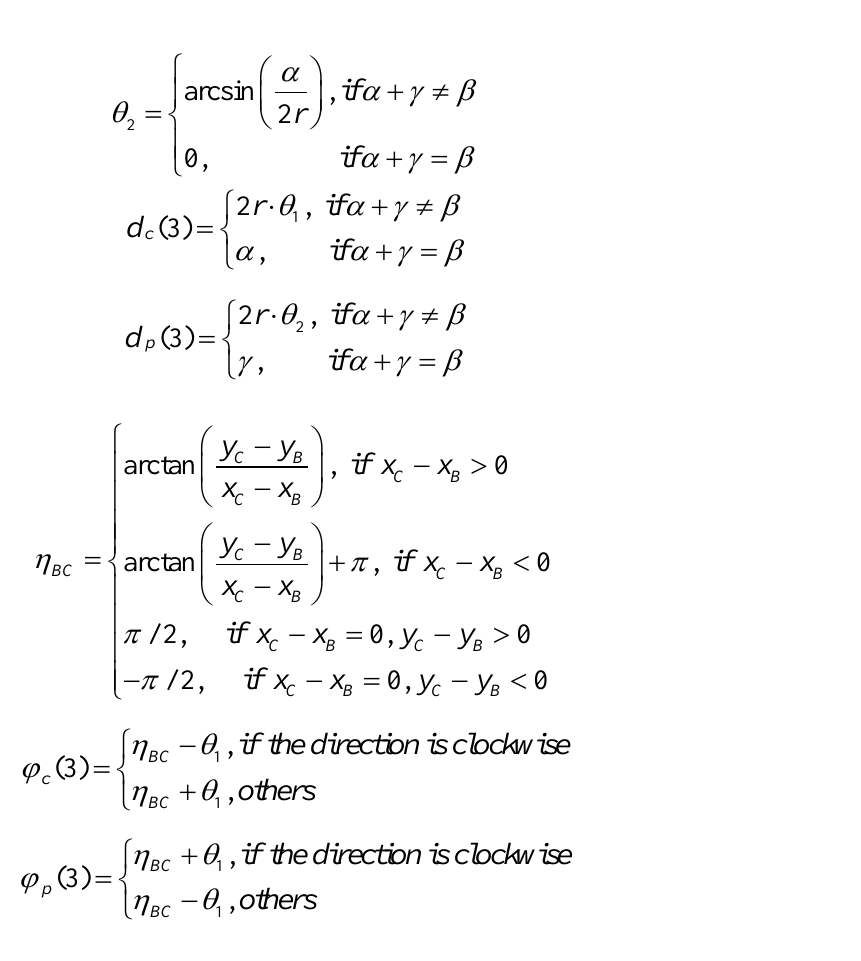
Figure 2. The geometrical relationship between the initial three